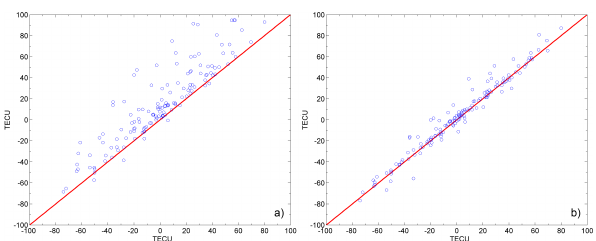
Figure 7. Scatter plot of the estimated offsets ( y axis) versus the true offsets ( x axis) with (a) spherical harmonics and (b) discrete Meyer at high resolution.